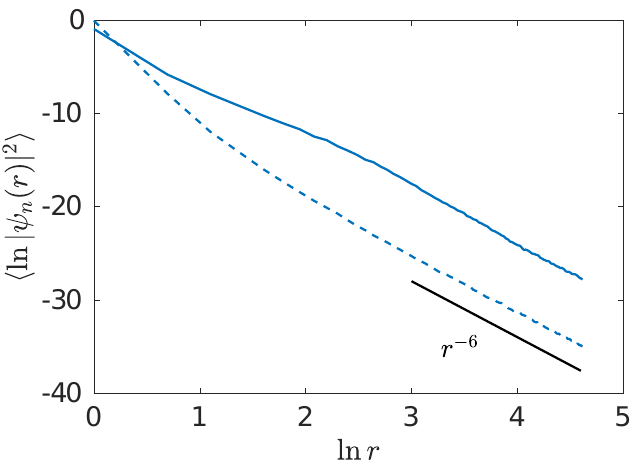
Figure 13: Power-law spatial decay of eigenstates in the bulk of the spectrum for a = 1 (solid), 3 (dashed), β = 0.5, at the system size L = 200 with 200 disorder realizations. The disorder amplitude is taken to be W = 20 for a = 1 and W = 200 for a = 3 in order to make the power-law tail dominant on moderate sizes in both